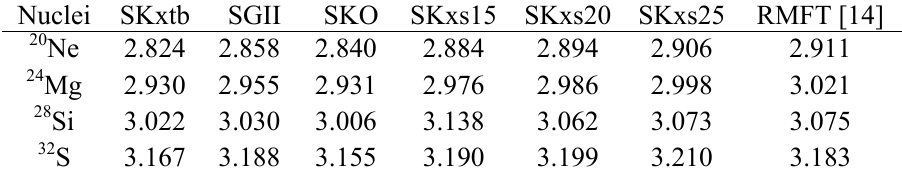
Table 3: Calculated proton rms radii compared with RMFT results.